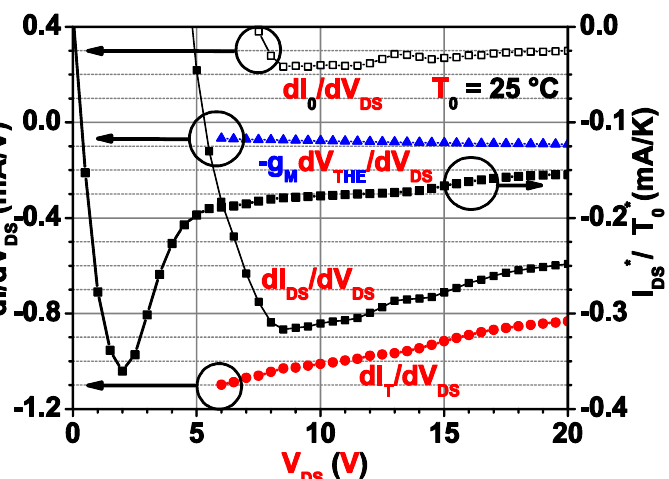
Figure 4. Transconductance g M , g M 0 and threshold voltage V TH and V THN dependence on V DS at various T 0 required for trapping phenomena incorporation.